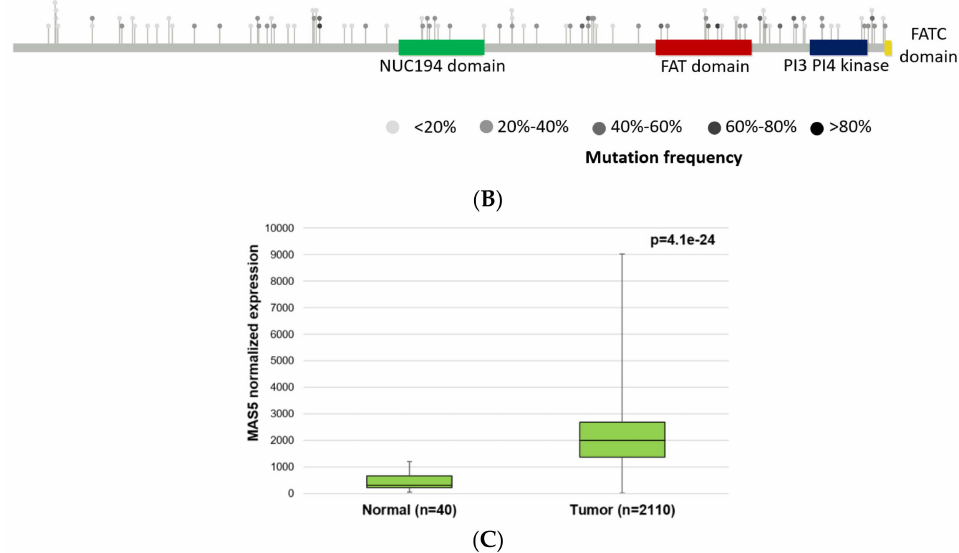
Figure 3. Localization of PRKDC mutations show uniform distribution in the entire gene using lollipop plot figures representing mutations in an information-dense manner indicating the positions in amino acid coordinates within the domain organization scheme of the gene ( A , B ). Some mutations are localized in annotated domains of PRKDC (NUC194, FAT, and PI3–PI4 kinase domains), while other mutations are localized in structurally/functionally unknown protein segments (grey line). Distribution of different types of mutations color coded in PRKDC ( A ) and mutation frequency for each sample using different shades of grey ( B ). Expression of PRKDC is significantly higher in colorectal cancer samples (microarray gene expression data from the NCBI Gene Expression Omnibus (GEO) database, see Section 4.8) ( C ).